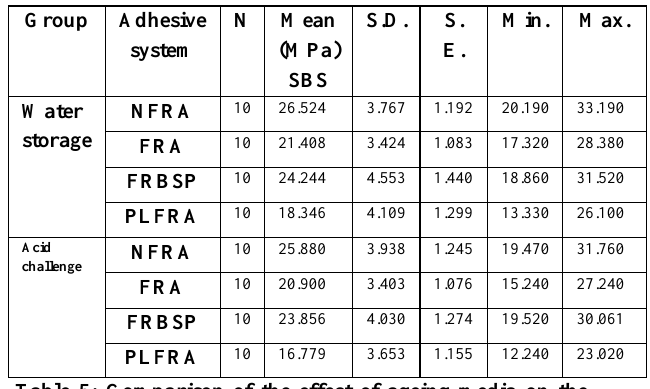
Table 4: Comparison of ARI among different adhesive systems in both ageing groups